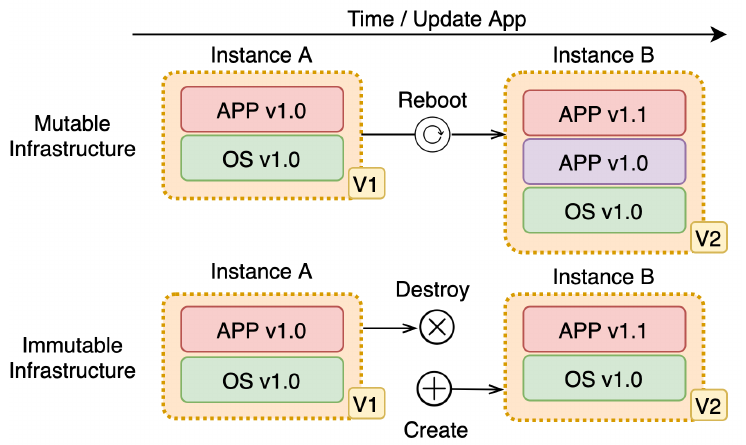
Figure 10. Difference between mutable and immutable deployment